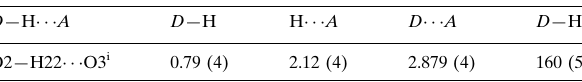
Hydrogen-bond geometry (A˚ , (cid:1)